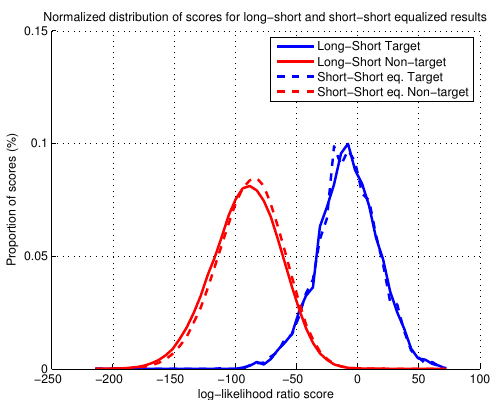
Figure 9. Normalized distribution of scores for Target (blue) and Non-target(red) trials of scenarios Long-Short (continuous line) and Short-Short Equalized (dashed line).Experiment carried out with SRE10 “coreext-coreext det5